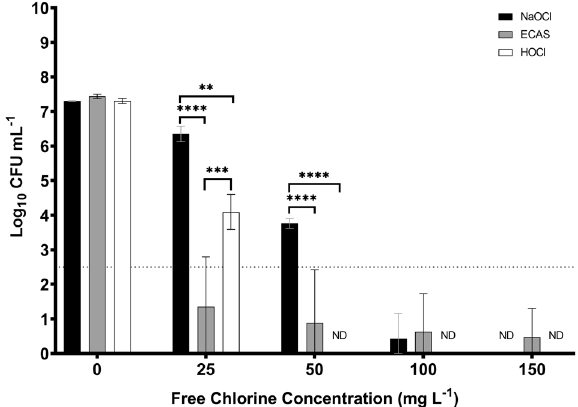
Fig. 2 Antimicrobial ef fi cacy of NaOCl, ECAS and HOCl against planktonic Escherichia coli with Clean BSA as an inhibitory solution. Antimicrobial ef fi cacy of NaOCl [black], ECAS [grey] and HOCl [white] using standardised free chlorine concentrations against E. coli ATCC 10536 with an interfering solution of 0.3 g L − 1 BSA ( 42 British Standards Institution,2009). Dotted line represents the minimum log reduction (5 log CFU mL − 1 ) required to demonstrate basic bactericidal activity under the experimental conditions of the assay ( n = 3 ± s.d.). Signi fi cant differences ( p -values) calculated through a two-way ANOVA with Tukey ’ s comparison post-test, with a con fi dence interval of 95% (**** p < 0.0001; *** p < 0.001; ** p < 0.01). ND = not detected. Error bars represent standard